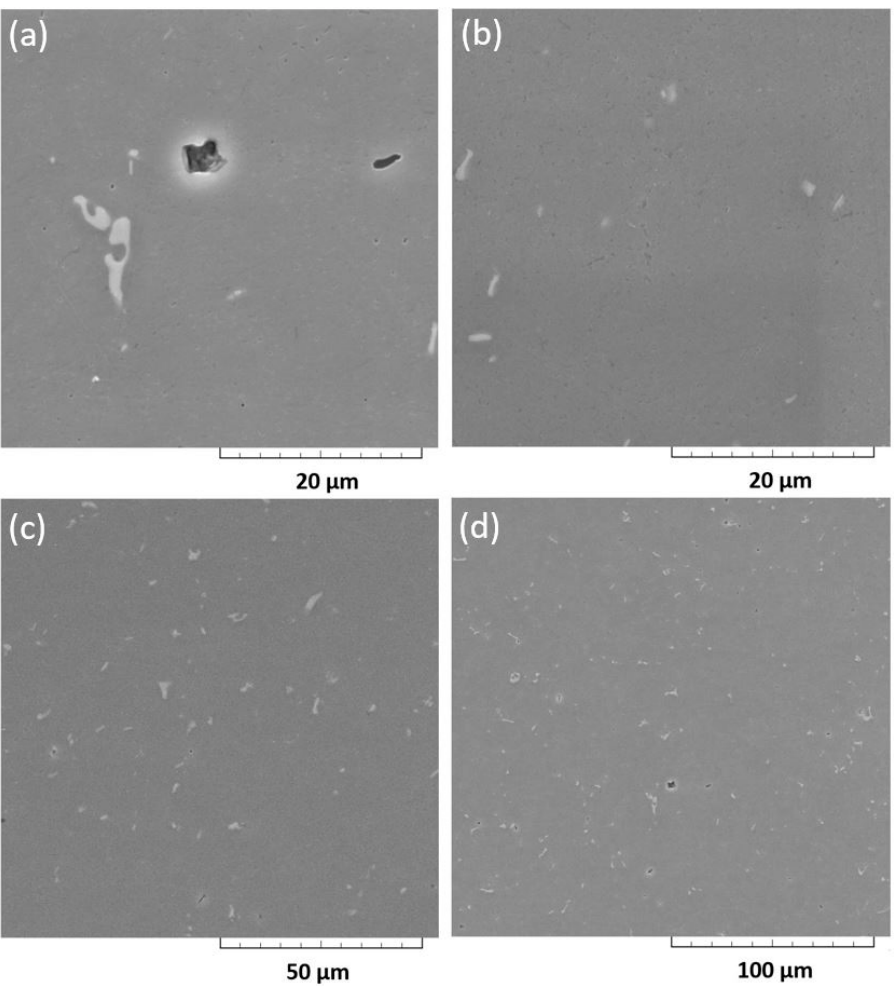
Figure 8. SEM images for SSR sample 12 and conventional EN AW 6082 extruded bar in T6 temper condition: ( a ) conventional sample with 5000 × magnification; ( b ) SSR sample 12 with 5000 × magnification; ( c ) SSR sample 12 with 2000 × magnification; ( d ) conventional sample with 1000 × magnification.